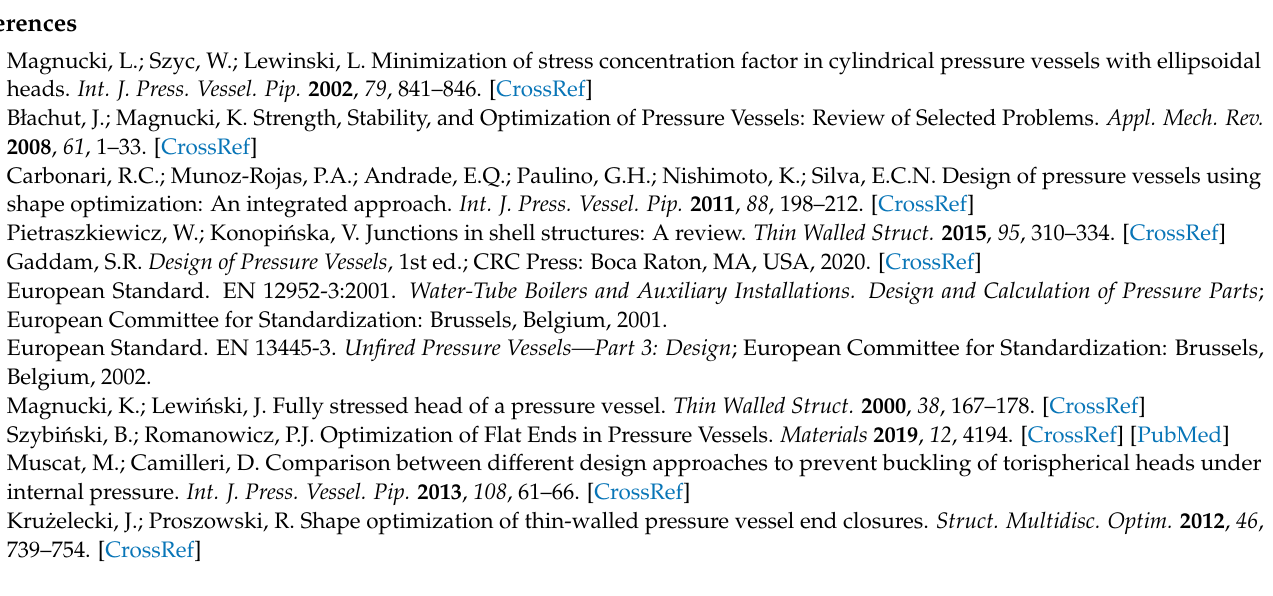
Figure A9. Repeatability of strain gauge measurements, non-optimal SRG, 2nd series: ( a ) cycles 6 and 10; ( b ) cycles 21 and 23; ( c ) cycles 14 and 24.